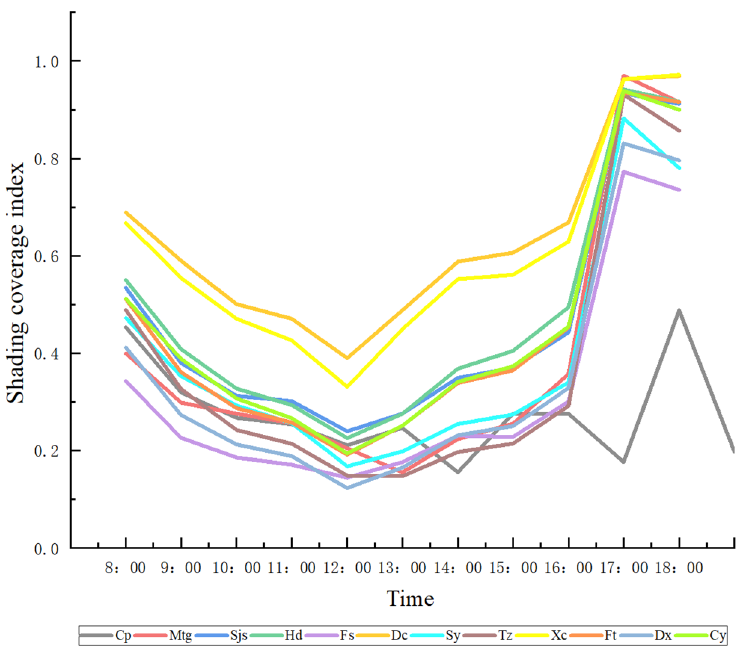
Figure 9. Line chart of shading coverage index for each administrative region. Each abbreviation means the following: Cp (Changping), Mtg (Mentougou), Sjs (Shijingshan), Hd (Haidian), Fs (Fang- shan), Sy (Shunyi), Tz (Tongzhou), Xc (Xicheng), Ft (Fengtai), Dc (Dongcheng), and Cy (Chaoyang).